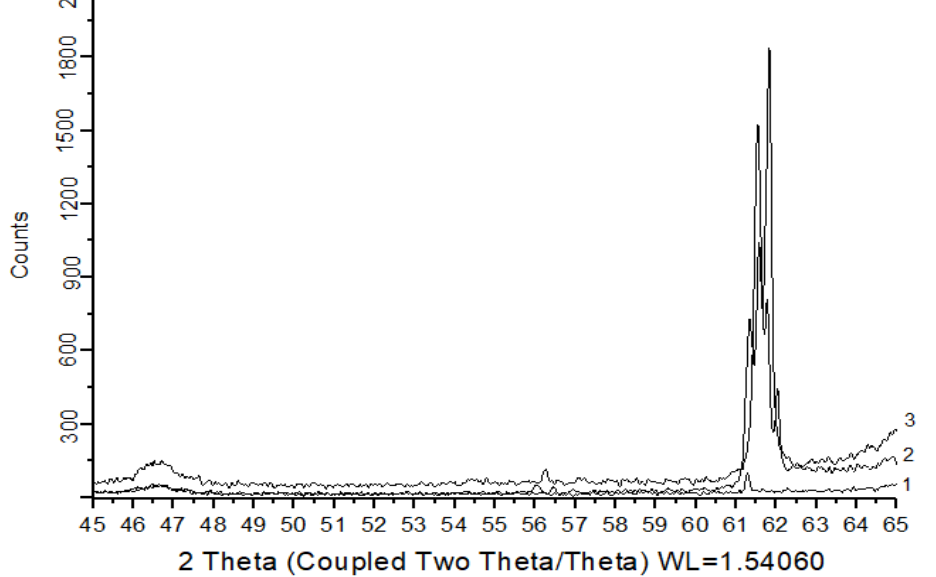
Figure 2. XRD patterns of the templates with nanoprecipitates formed by chemical deposition: the deposition duration was 15 min (1), 20 min (2), and 25 min (3).